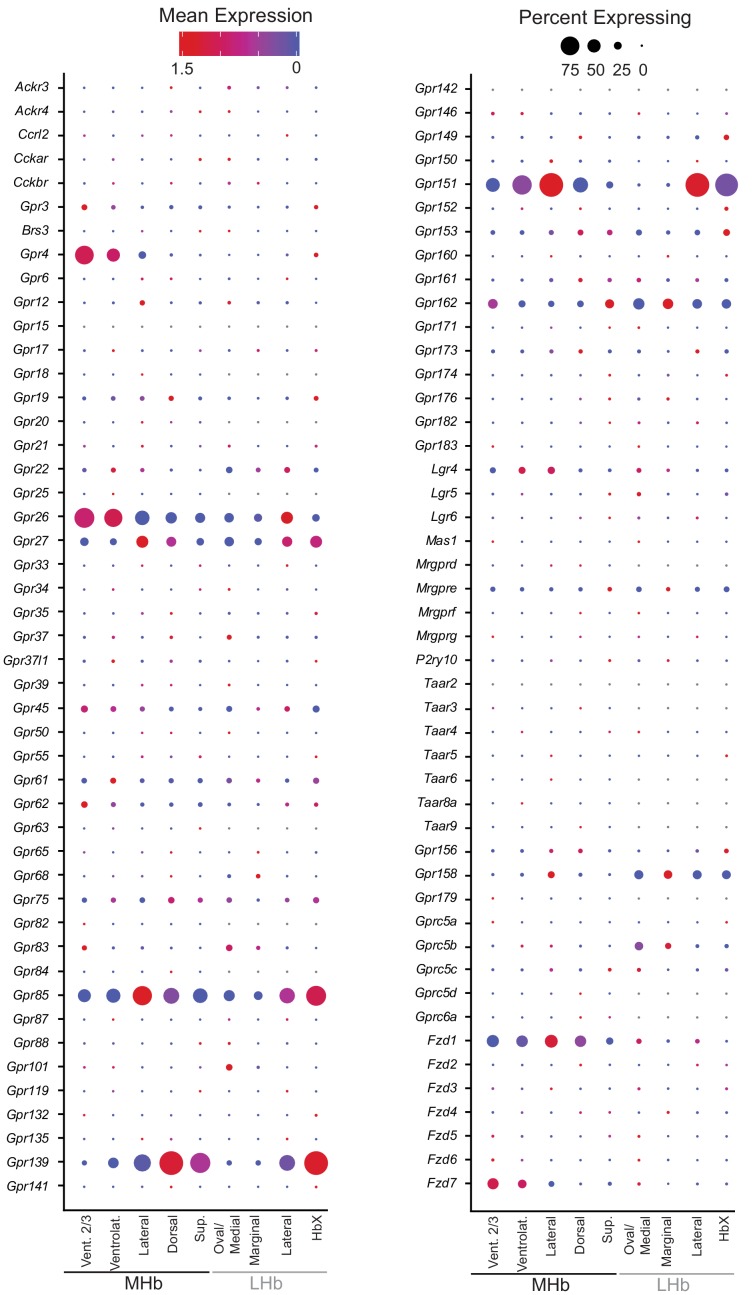
GPCR diversity in MHb and LHb neuronal subtypes (part 2).Dot plot displaying gene expression of all GPCRs detected in MHb and LHb neurons (Harding et al., 2018; Regard et al., 2008). Genes are grouped and listed alphabetically by receptor family name (Adenosine Receptors, Somatostatin Receptors, etc.). The color of each dot (blue to red) indicates the relative expression of each gene whereas the dot size indicates the fraction of cells expressing the gene.